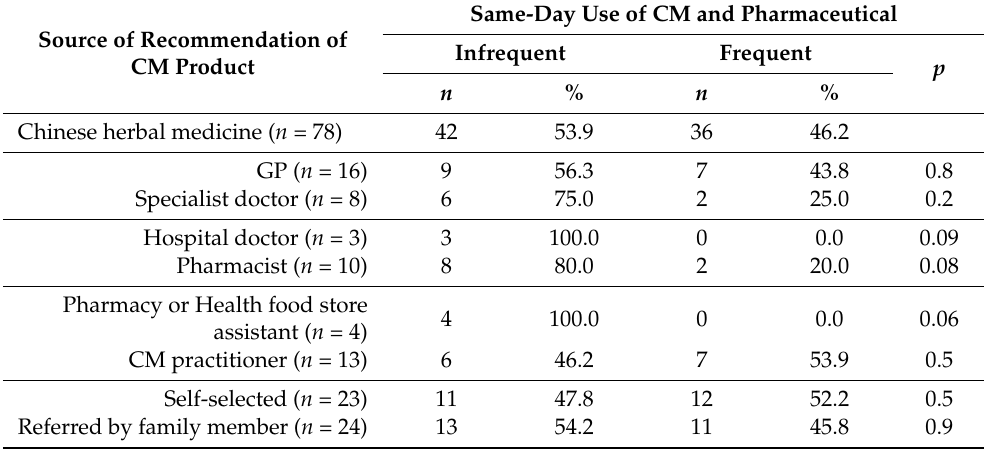
Table 4. Sources of Recommendation for Participants Using Orally Administered CM